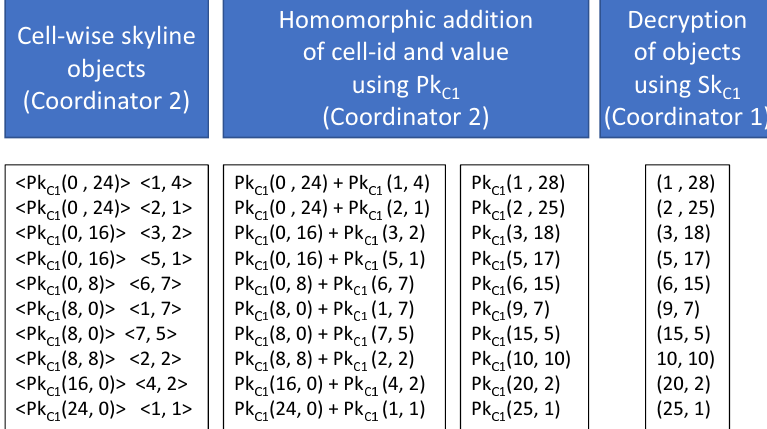
Figure 6. Homomorphic addition by Coordinator 2 and decryption of global skyline objects by Coordinator 1. Here, Pk C 1 ( x , y ) means ( x , y ) is encrypted by Coordinator 1’s public